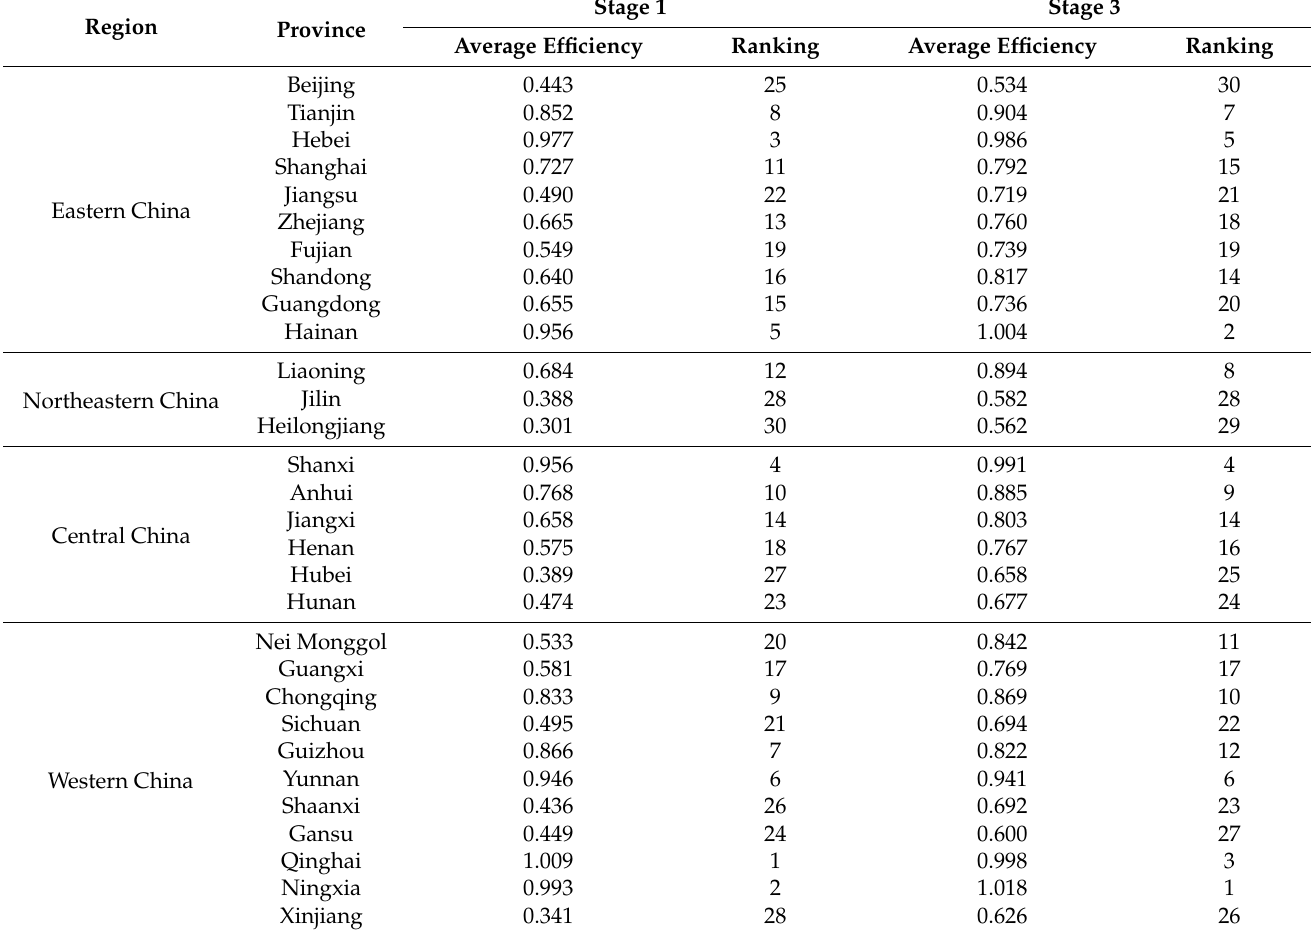
Table 2. Efficiency averages and rankings by province from 2008 to